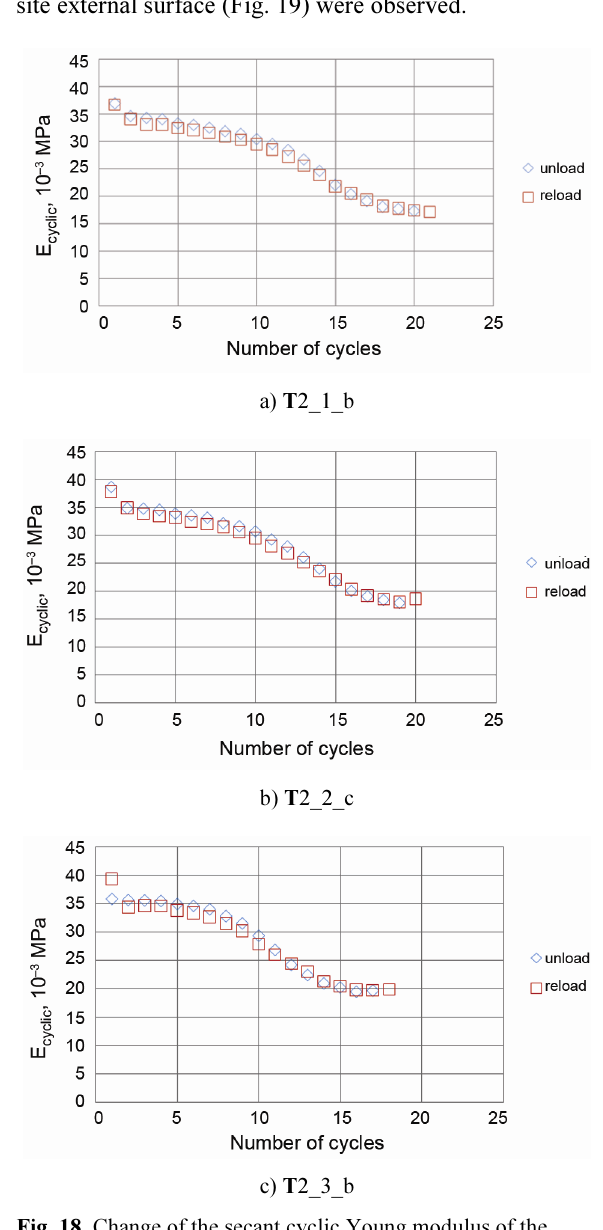
Fig. 18. Change of the secant cyclic Young modulus of the specimens T 2_1_b, T 2_2_c and T